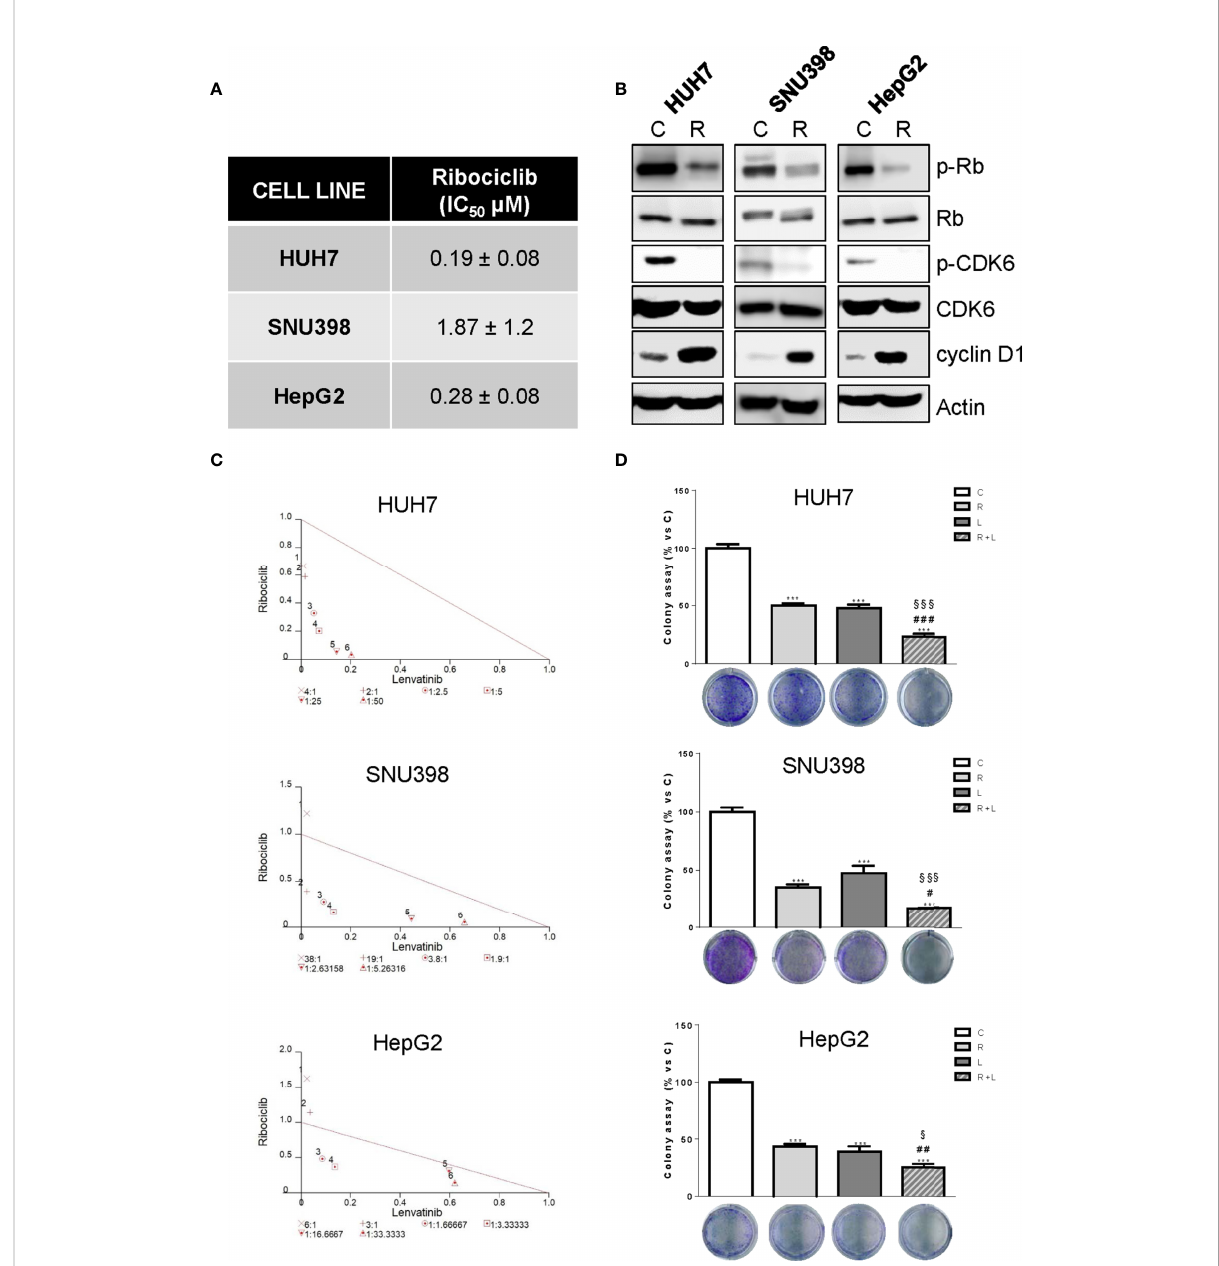
FIGURE 3 Ribociclib and lenvatinib combination exerts additive anti-proliferative effects in HCC cells and inhibits colony formation more strongly than single agents. (A) After 24h from seeding, HUH7, SNU398, and HepG2 cells were treated with increasing concentrations of ribociclib (R) for 6 days. Cells proliferation was evaluated by CV assay and the IC 50 values were calculated using GraphPad Prism 6.00 software. (B) HCC cells were untreated (C) or treated with 1 m M R for 24h. The cells were lysed and the expression of the indicated proteins was evaluated by Western blot analysis. (C) Cells were treated with R, L or the combination. The growth medium with drugs was refreshed every 3 days. After 6 days, cell proliferation was assessed by CV assay. Combination indexes were calculated with Calcusyn software. (D) HUH7, SNU398, and HepG2 cells were treated with R or L at their corresponding IC 50 values alone or in combination. After 6 days, colony formation was assessed by CV assay. Representative images of crystal violet staining of colonies are shown. ***p<0.001 vs C; # p<0.05, ## p<0.01 ### p<0.001 vs R; § p<